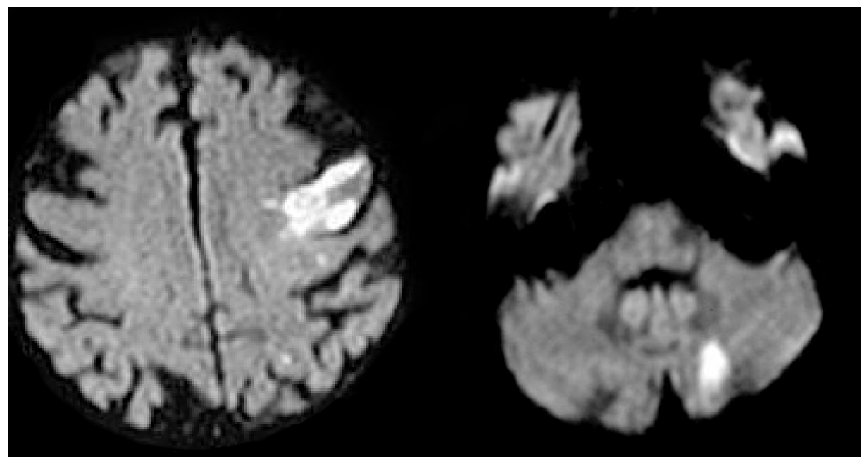
Topographic distribu- tion of acute DWI le- sions and stroke aeti- ology. DWI visualised acute lesions in the left middle cerebral artery territory (low ADC values; not shown), correspon- ding to the clinical symptom of aphasia and mild hemiparesis on the right. Addi- tional – clinically silent – acute DWI le- sions were shown in the left cerebellum. Stroke aetiology was atrial